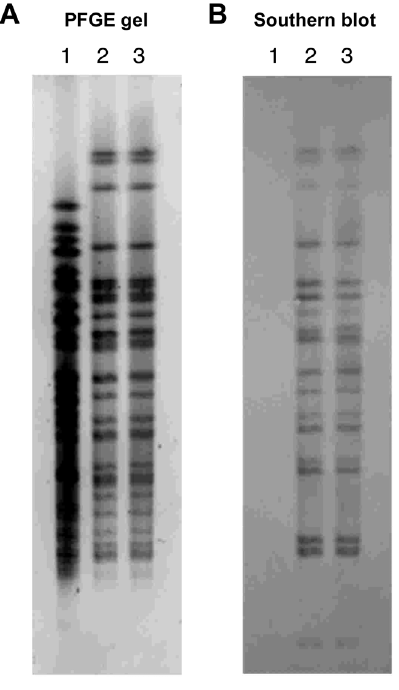
Figure 5. Pulsed Field Gel Electrophoresis and Southern blot analyses using IS Pa 8-specific probe. (A) PFGE gel of Spe I chromosomal digests of wild-type strain PAO1, parent isolate PA42, and mutant 812M visualized using SYBR gold. (B) Southern blot of the gel depicted in Figure 5(A) using an IS Pa 8-specific probe. Lane 1, PAO1 (negative control); lane 2, parent isolate PA42; lane 3, mutant 812M.